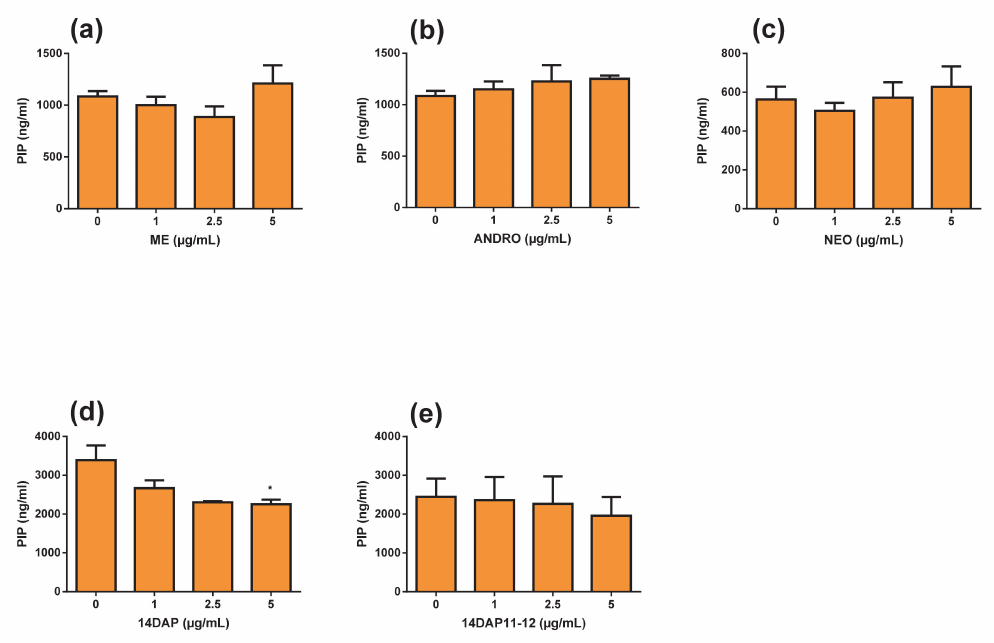
Figure 8. E ff ect of ME, ANDRO, NEO, 14DAP, and 14DAP11-12 on procollagen type I C-peptide (PIP) production. HDFa were treated with increasing concentration (1, 2.5 or 5 µ g / mL) of ME ( a ), ANDRO ( b ), NEO ( c ) 14DAP ( d ), or 14DAP11-12 ( e ) for 48 h. PIP was determined by an ELISA. The values mean ± S.D. * p < 0.05, ** p < 0.01 compared with control group, n =